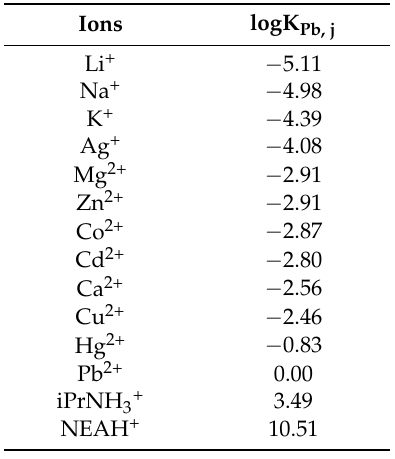
Table 2. Potentiometric selectivity of the PVC-based electrode membrane containing ligand rac - 4 and DOS as a plasticizer for different metal ions and protonated primary amines.